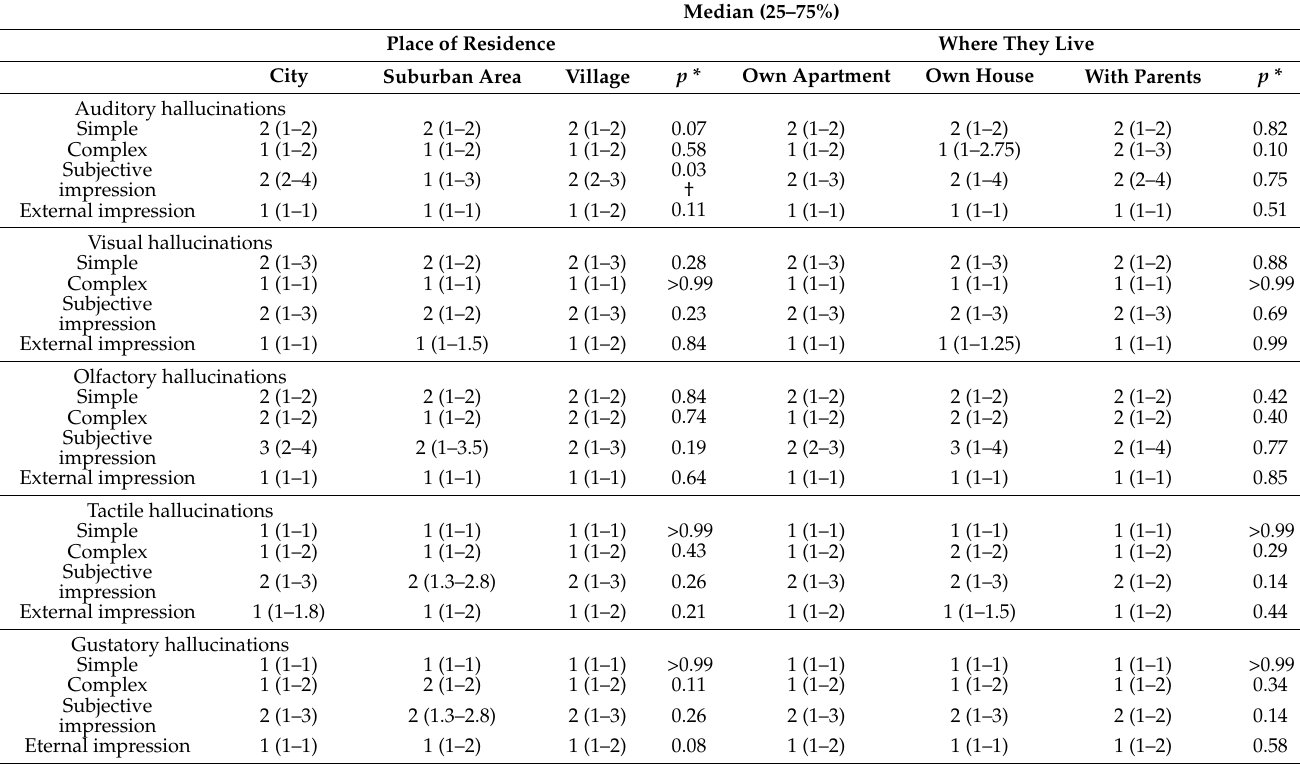
Table 5. Frequency of simple and complex, and according to the impression of subjective and external hallucinations in relation to the place of residence and where they